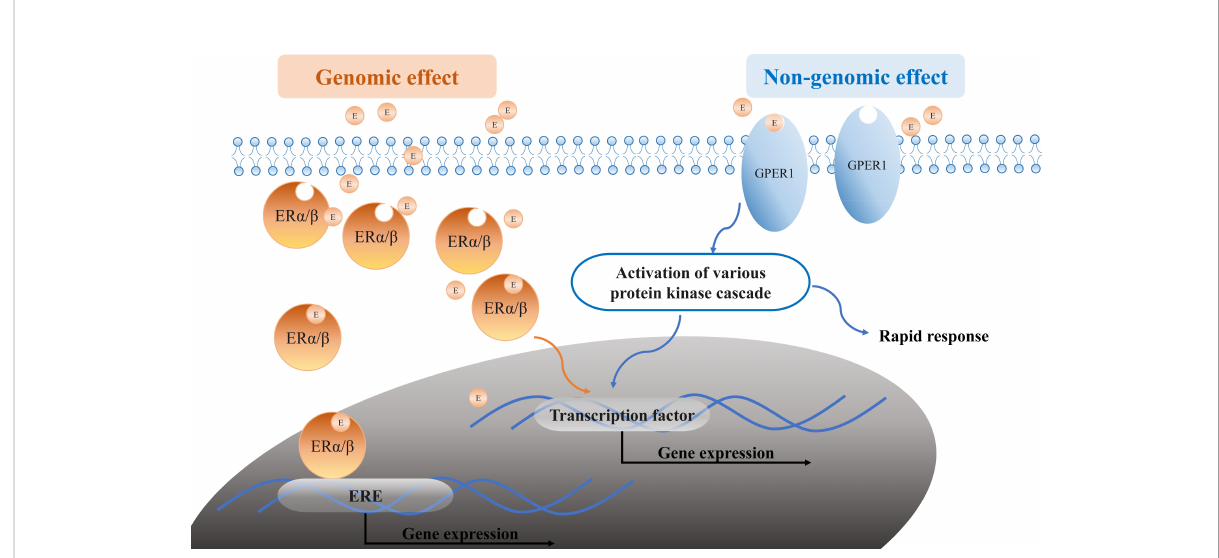
FIGURE 5 Estrogen signaling pathways. Estrogen or E2 (orange circle E in the graph) binds to the ER a /ER b and GPER1, exerting its genomic and non- genomic effects. The genomic effect is shown in orange: the E2-receptor complex binds to EREs upon entry into the nucleus. The non- genomic effect is shown in blue: E2 binds to ERs in the membrane-like GPER1 and regulates the expression by modulating the ion channel opening or activation of related enzymes. E, estrogen or E2; ER a , estrogen receptor alpha; ER b , estrogen receptor beta; GPER1, G protein- coupled estrogen receptor 1; ERE, estrogen response elements; PI3K, phosphatidylinositol 3-kinase; MAPK, mitogen-activated protein